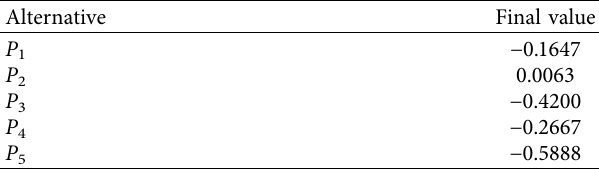
Table 12: The final value.